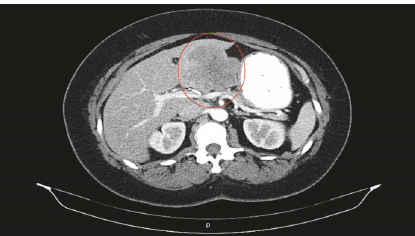
Figure 1: Contrast enhanced computed tomography scan. The image demonstrates a large left hypoattenuating hepatic lobe mass measuring 7.8 ×